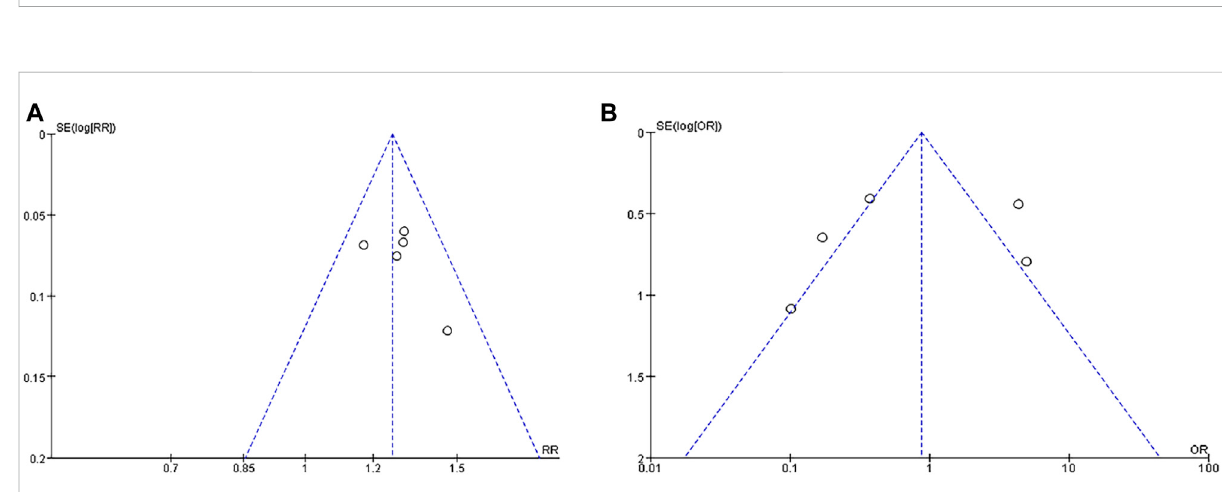
FIGURE 9 Funnel plot indicating publication bias for treatment effectiveness (A) and adverse events rate (B)